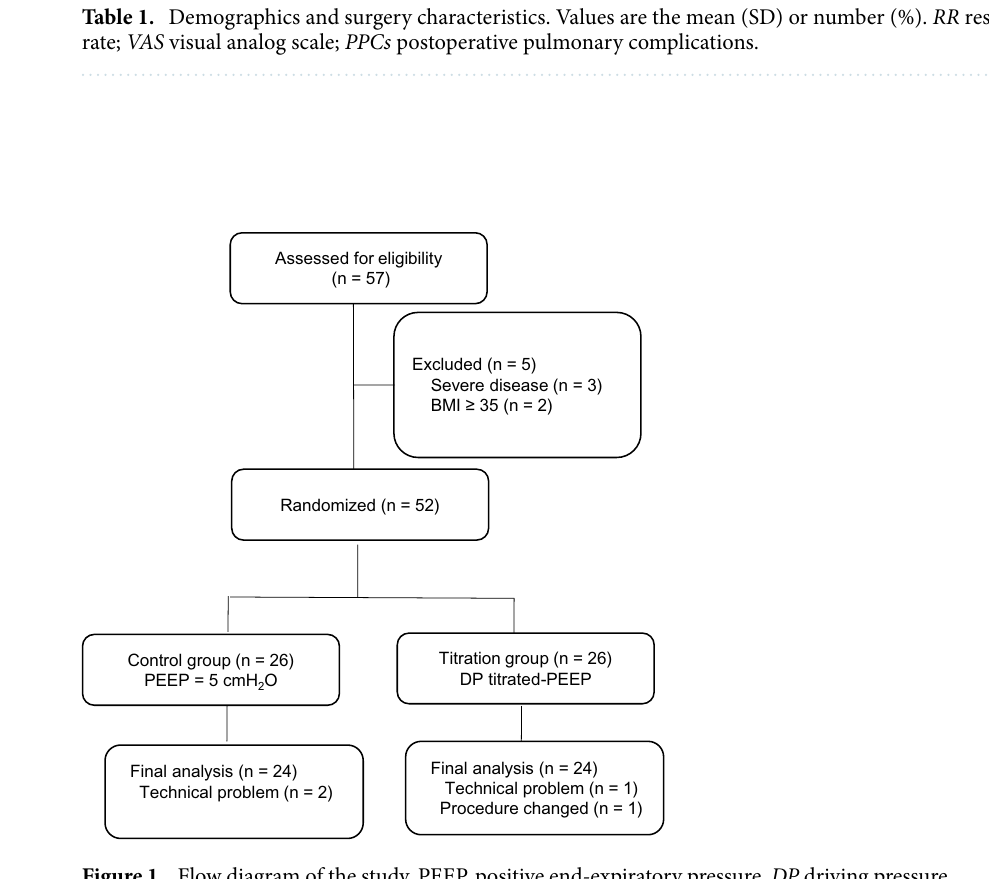
Figure 1. Flow diagram of the study. PEEP, positive end-expiratory pressure. DP driving